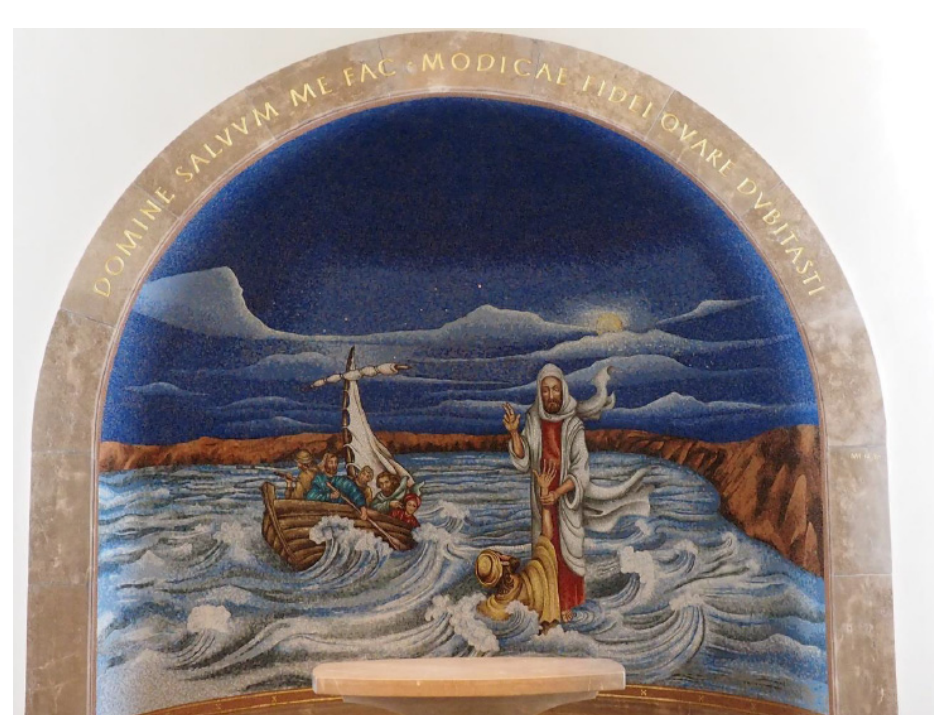
Figure 11. Christ Calming the Storm (photo: Assaf Pinkus).